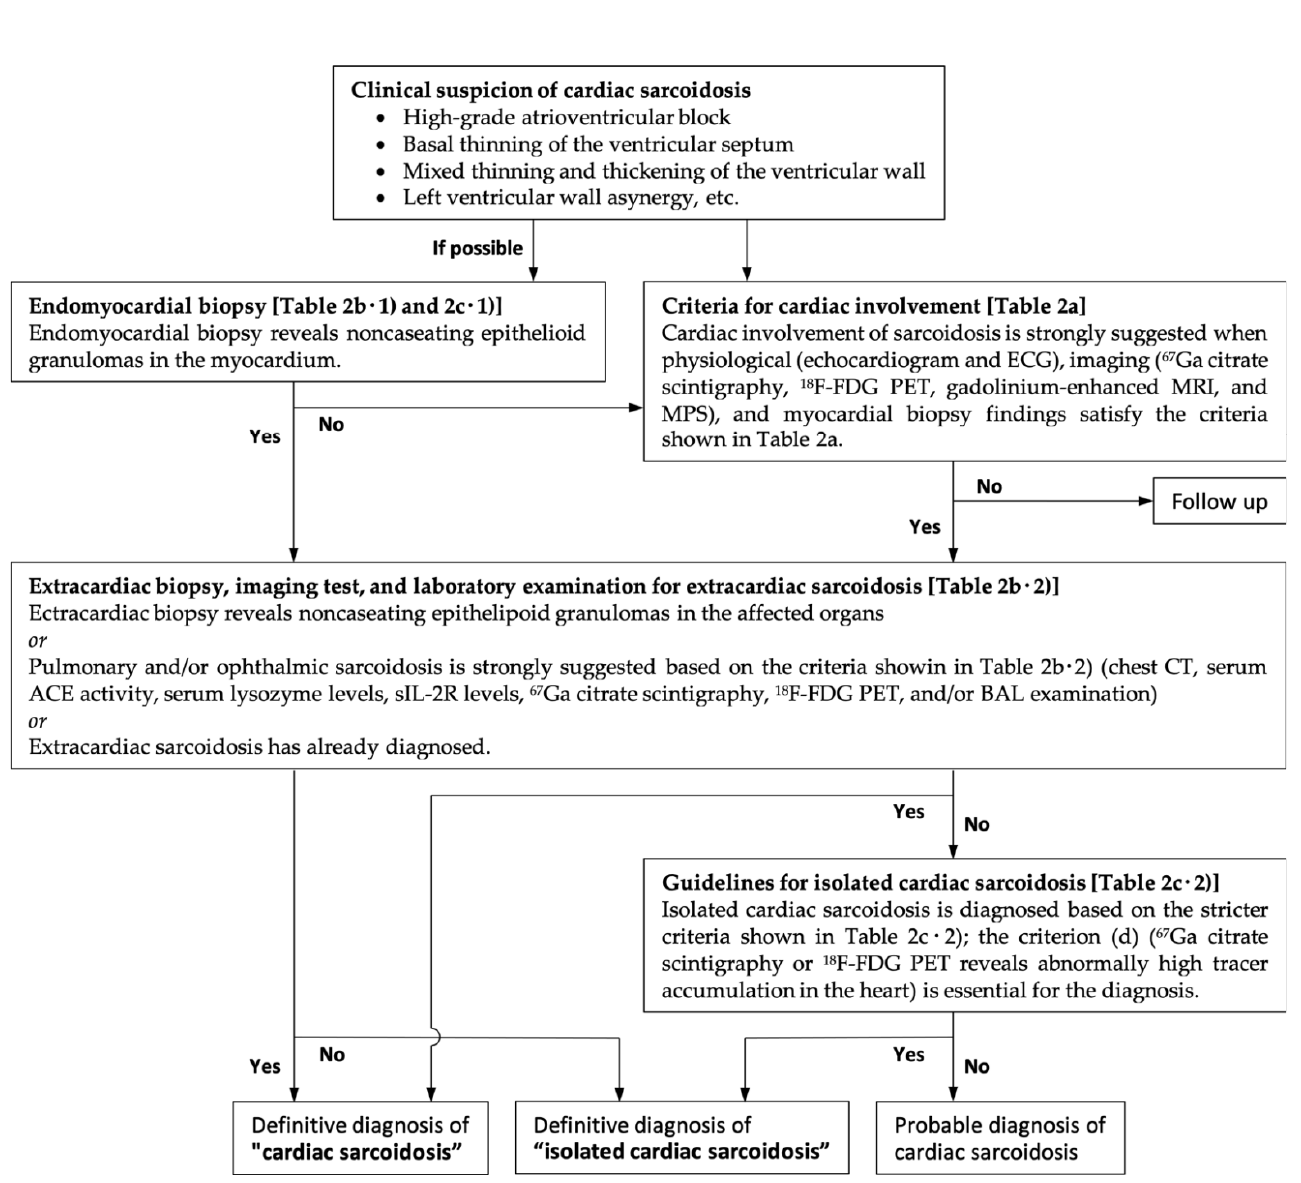
Figure 1. The diagnostic algorism for cardiac sarcoidosis based on the revised Japanese Ministry of Health and Welfare criteria. ECG, electrocardiogram; 67 Ga, gallium-67; 18 F-FDG PET, fluorine-18 fluorodeoxyglucose positron emission tomography; MRI, magnetic resonance imaging, MPS, myocardial perfusion scintigraphy; CT, computed tomography; ACE, angiotensin converting enzyme; sIL-2R, soluble interleukin 2 receptor, BAL, bronchoalveolar lavage.